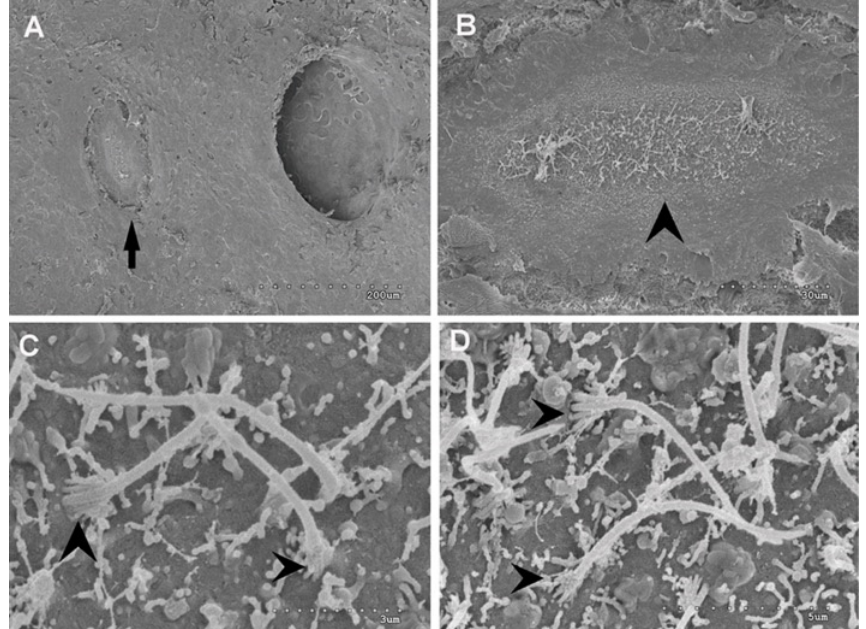
Figure 22. SEM. Superficial neuromast. ( A ) Upper view of a superficial neuromast . ( B ) Normal aspect of hair cell bundles on superficial neuromast of a control salmon. ( C , D ) Hair cell bundles on superficial neuromast of a 12-week exposed salmon. No lesions are visible. Scale bar: ( A ) = 200 µm. ( B ) = 30 µm. ( C ) = 5 µm. ( D ) = 3 µm.